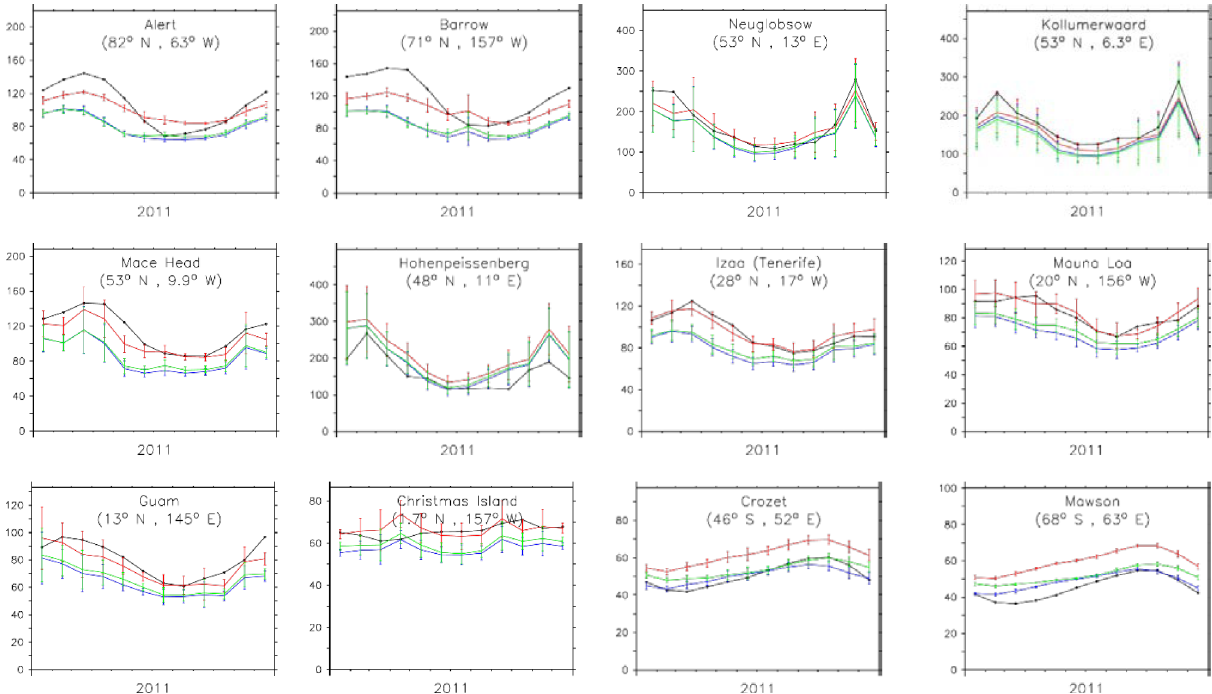
Figure 10. Comparison of CO mixing ratios (ppbv) at the surface as simulated (red, blue and green are model results from CBA, MOC and MOZ, respectively) and observed (black) at 12 stations sorted by decreasing latitudes. The bars represent 1 standard deviation of the monthly average for the location of the station.